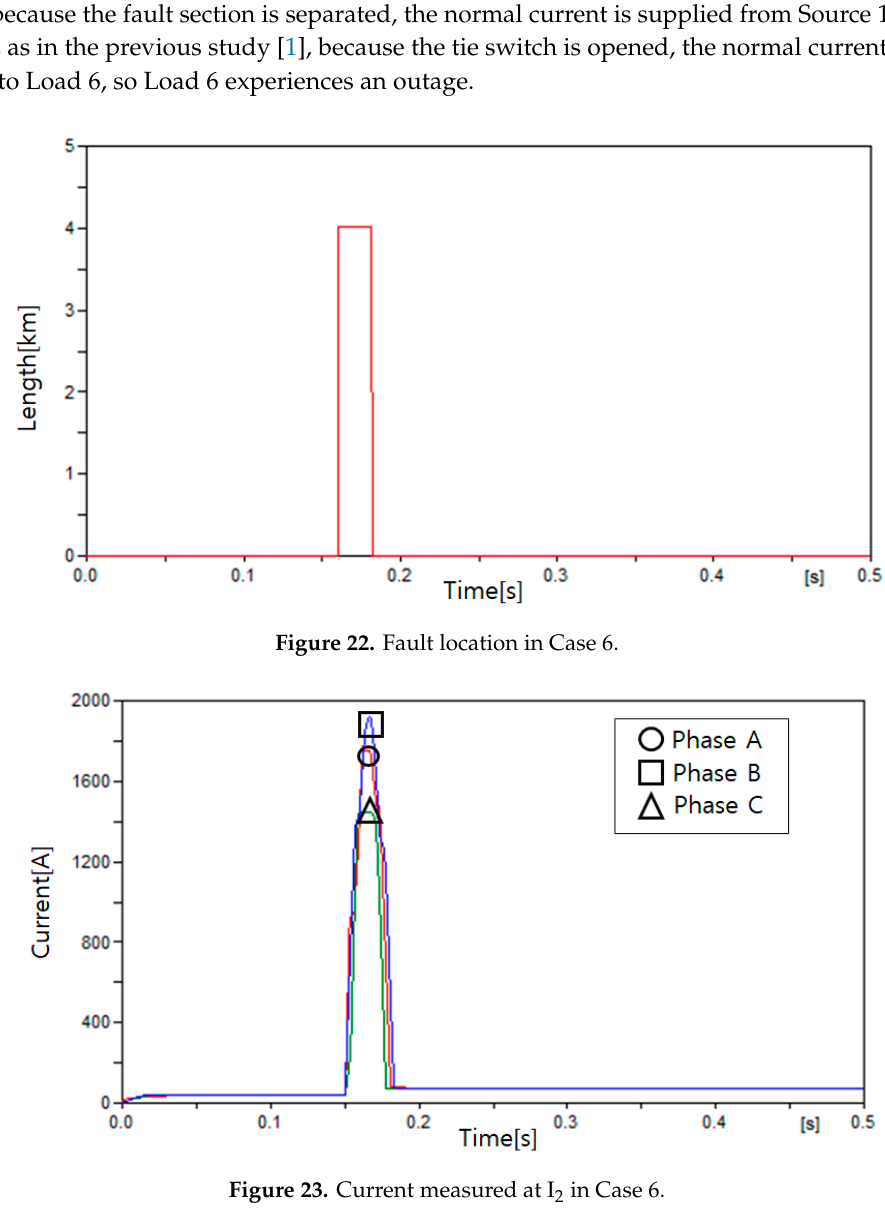
Figure 24. Current measured at Load 6 in Case 6.